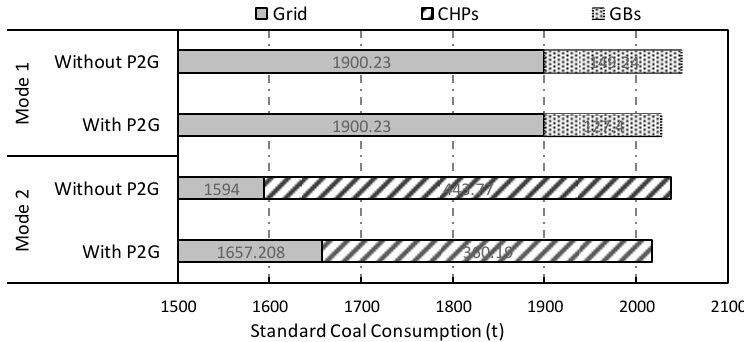
Figure 8. Standard coal consumption of two modes. Table 2. Standard coal consumption per kilowatt hour of each unit.